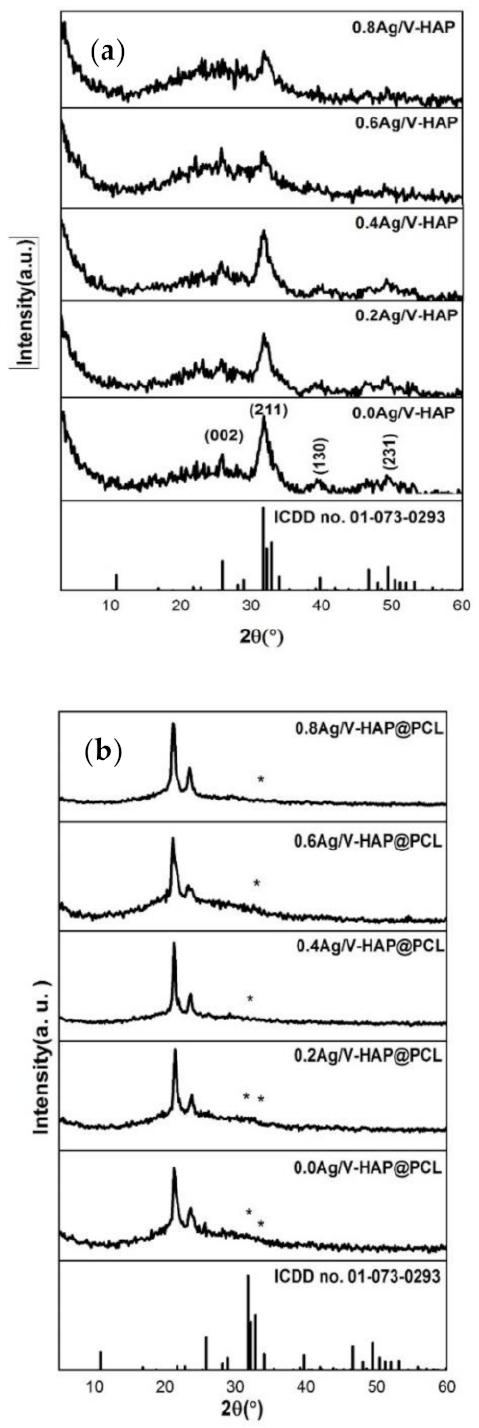
Figure 1. ( a , b ) X-ray diffraction (XRD) pattern of HAP modified with co-doped Ag/V and incorpo- rated into polycaprolactone nanofibers: ( a ) Ag/V-HAP in powder phase and ( b ) Ag/V-HAP@PCL in nanofibrous composition (*: